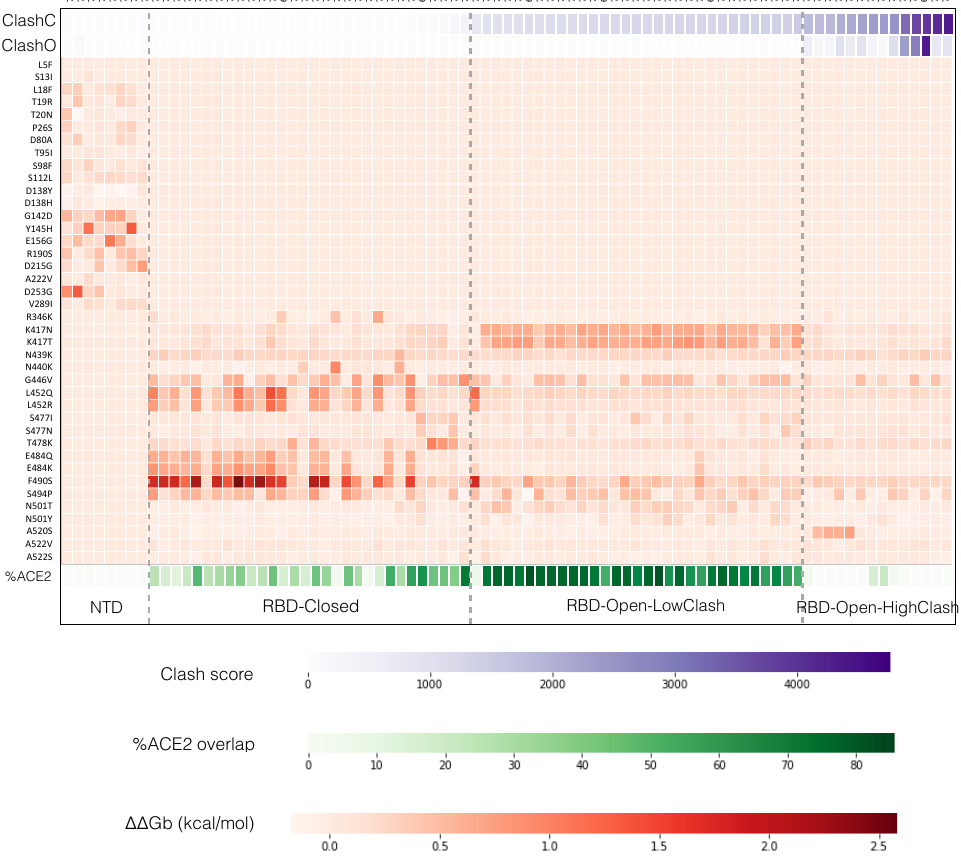
Figure 2. Heatmap in which each column corresponds to one of the 83 neutralizing antibodies (nAbs)-spike protein structures from the D nAb-spike dataset, indicated by their PDB code and ordered according to their clash score in the closed conformation. Row 1 and 2: clash score when the nAb-spike protein complex is superimposed onto the full trimeric spike protein structure in closed (ClashC) and 1-open (ClashO) conformations, respectively; the scale shown below is in number of clashing atom pairs. Rows 3-42: Predicted change in binding affinity upon mutation ( ∆∆ G b ), for the 40 variants studied, specified in ordinate; the free energy scale in kcal/mol is given below. Row 45: overlap between the epitope and the angiotensin-converting enzyme 2 (ACE2) binding region on the spike protein surface; the scale, in % of the ACE2 binding residues, is indicated below. The three vertical dashed lines indicate the four classes specified